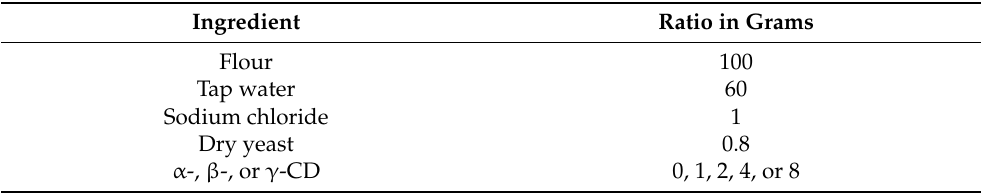
Table 1. Recipe for bread used in Breadmaking I and Breadmaking II.